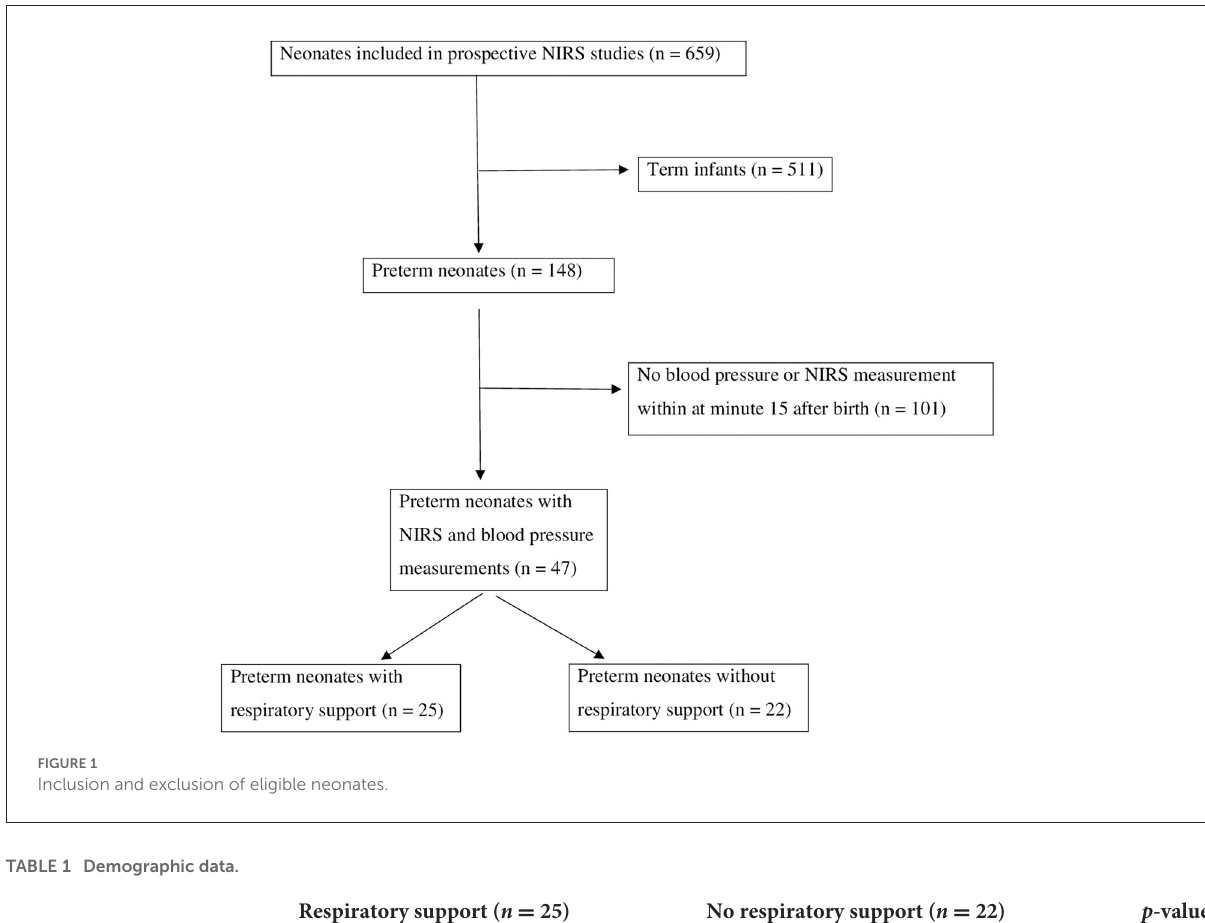
TABLE 1 Demographic